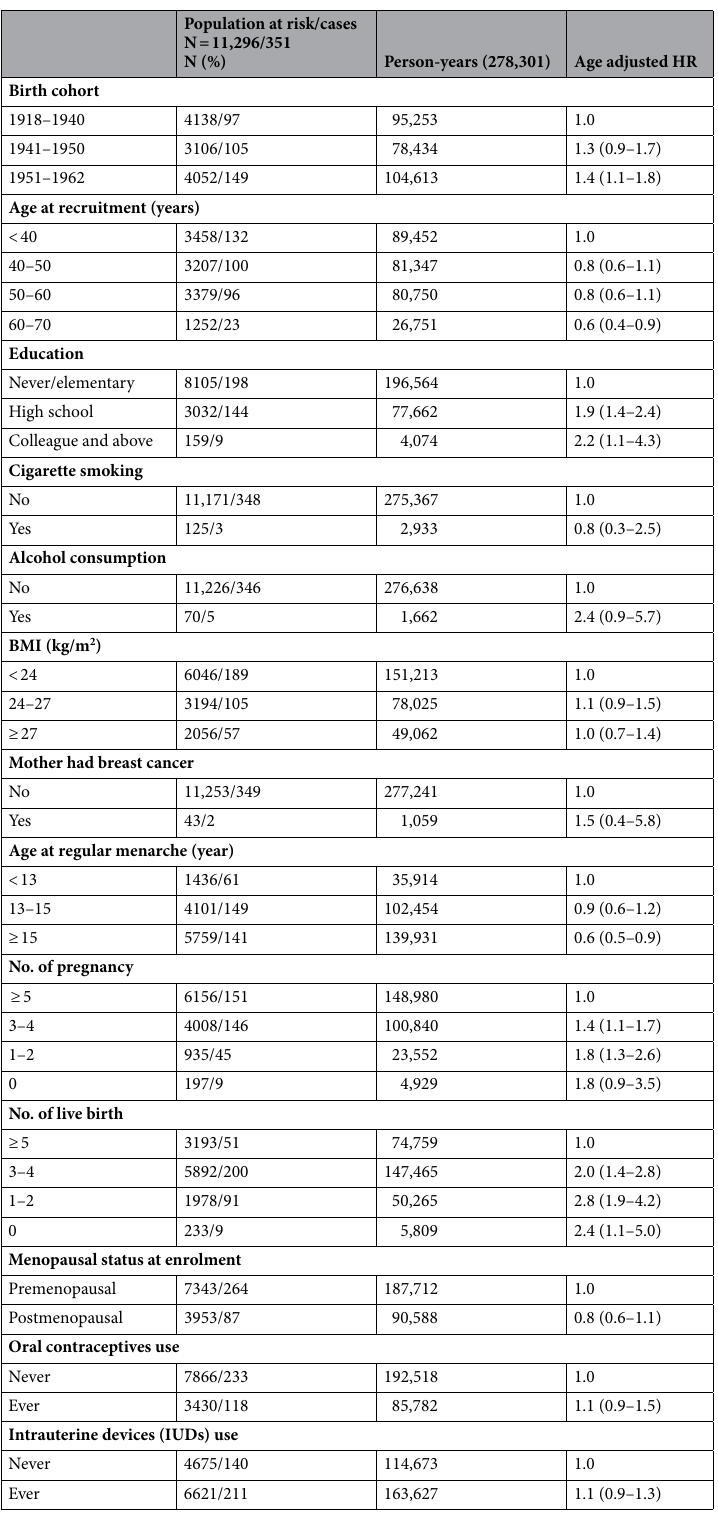
Table 1. The hazard ratios (HR) of selected variables for breast cancer, the cancer screening program cohort. BMI body mass index, HR hazard